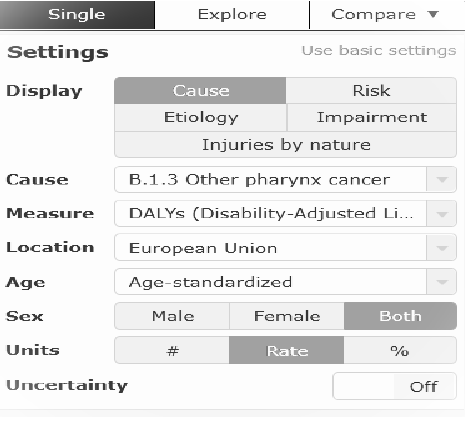
Figure 1. Search strategy employed to obtain relevant Irish LOCP tobacco associated data from IHME database. Source: Institute for Health Metrics Evaluation. Used with permission. All rights reserved [1].